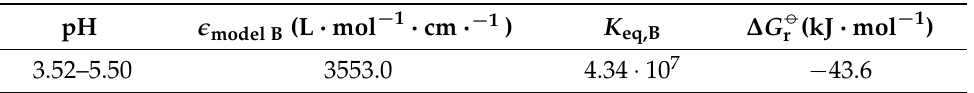
Table 3. Parameters obtained by fitting of Model B (for the reactive species H 2 GA 2 − ) to the experi- mental points of the Job plot.